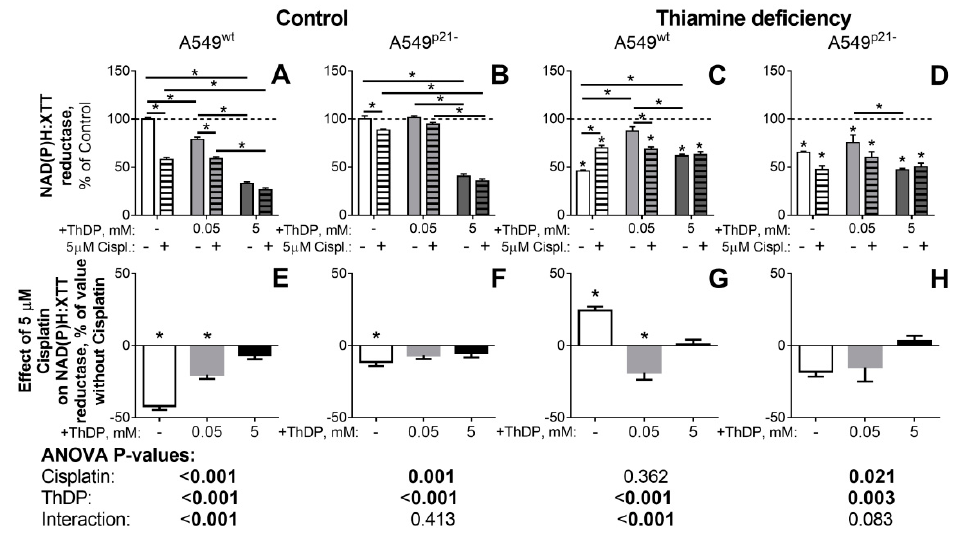
Figure 5. Influence of cisplatin (Cispl.) on p21-dependent responses of NAD(P)H:XTT reductase activity of A549 cells to variation in the thiamine / ThDP levels. A549 wt ( A , C , E , G ) or A549 p21- ( B , D , F , H ) cells were cultured in DMEM prepared with 4 mg / L thiamine hydrochloride (Control, A, B, E, F) or without thiamine (Thiamine deficiency, C, D, G, H). 24 h after supplementation with indicated concentrations of ThDP (shades of grey) and / or cisplatin (5 µ M, hatched columns), NAD(P)H:XTT reductase activity was assayed. Values obtained without ThDP supplementation are presented by white columns, those at 0.05 or 5 mM ThDP—by gray or black columns, correspondingly. In the upper part (A–D), cellular NAD(P)H:XTT reductase activity is normalized to the activity of the control A549 wt or A549 p21- cells to show combined e ff ects of thiamine / ThDP and cisplatin on cellular viability. In the lower part (E-H), cellular NAD(P)H:XTT reductase activity is normalized to the corresponding value without cisplatin to show the specific e ff ect of cisplatin under each variation in the thiamine / ThDP levels. The data of at least three independent experiments are presented as mean ± SEM. Statistically significant di ff erences ( p < 0.05, shown by asterisks) are determined by two-way ANOVA followed by Tukey’s post hoc test. Horizontal lines show the groups compared. Asterisks above the bars in C and D indicate the statistically significant di ff erences between the corresponding thiamine deficient cells and cells with standard thiamine level. Asterisks in E–G indicate the statistically significant e ff ects of cisplatin vs the same condition without cisplatin. ANOVA significances of the factors (cisplatin and ThDP) and their interactions are given below the graphs, with significant ( p < 0.05) values in